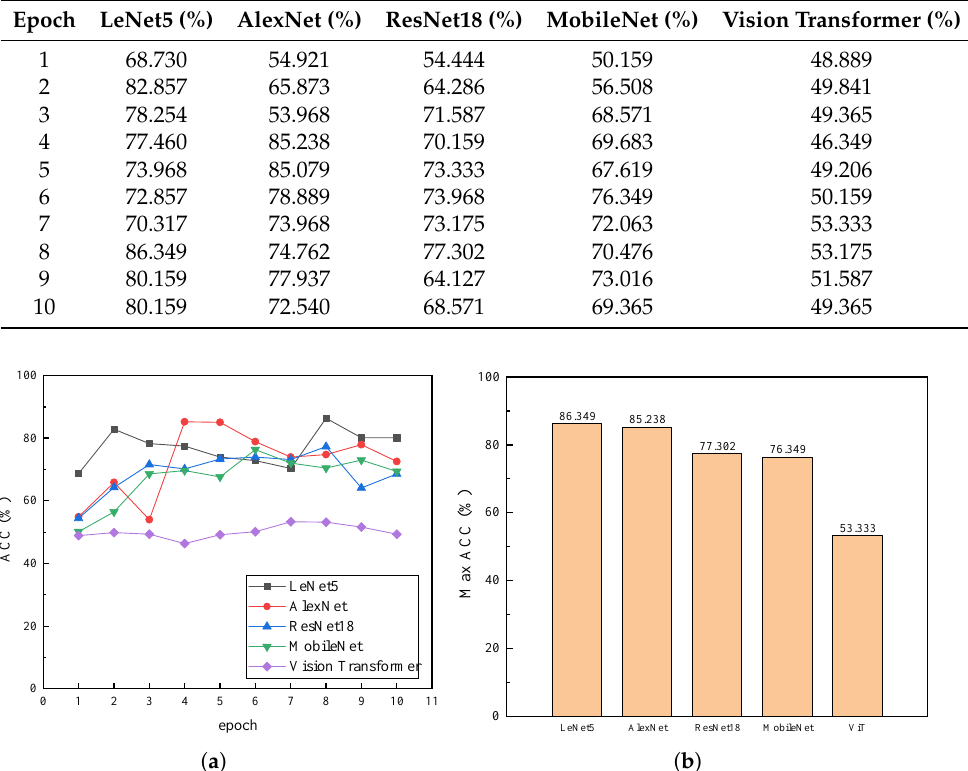
Table 5. Accuracy of pneumonia recognition by each model before data augmentation and before GPU loading.